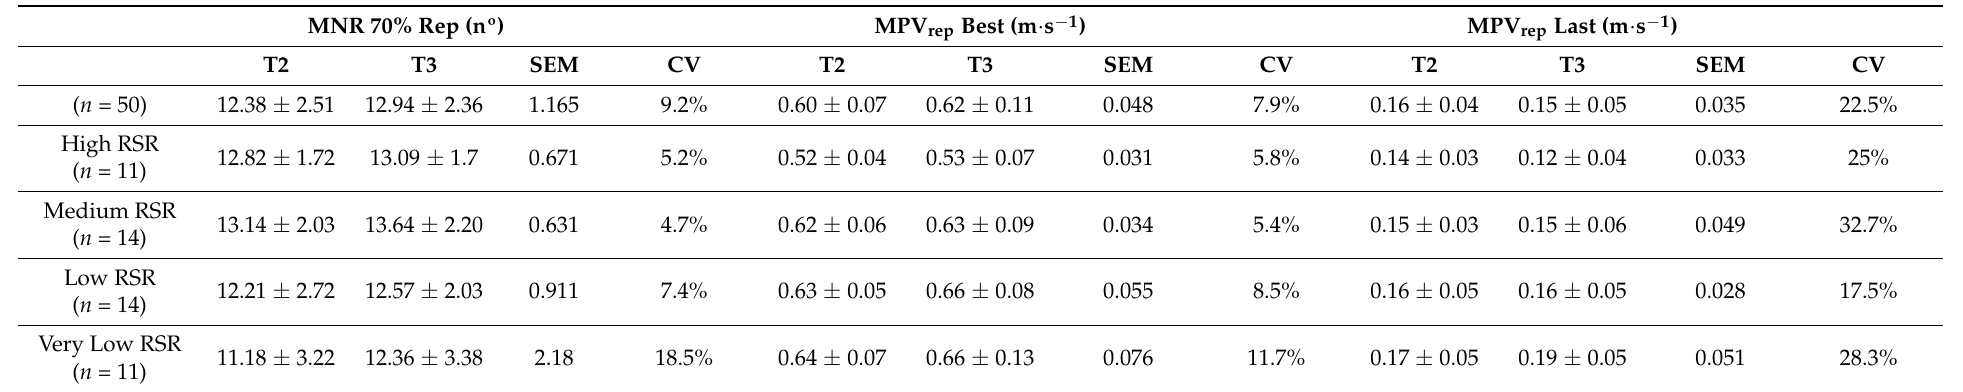
Table 2. Intrasubject variability in the number of repetitions performed before failure (MNR), MPV rep Best, and MPV rep Last on two different days according to strength (RSR).